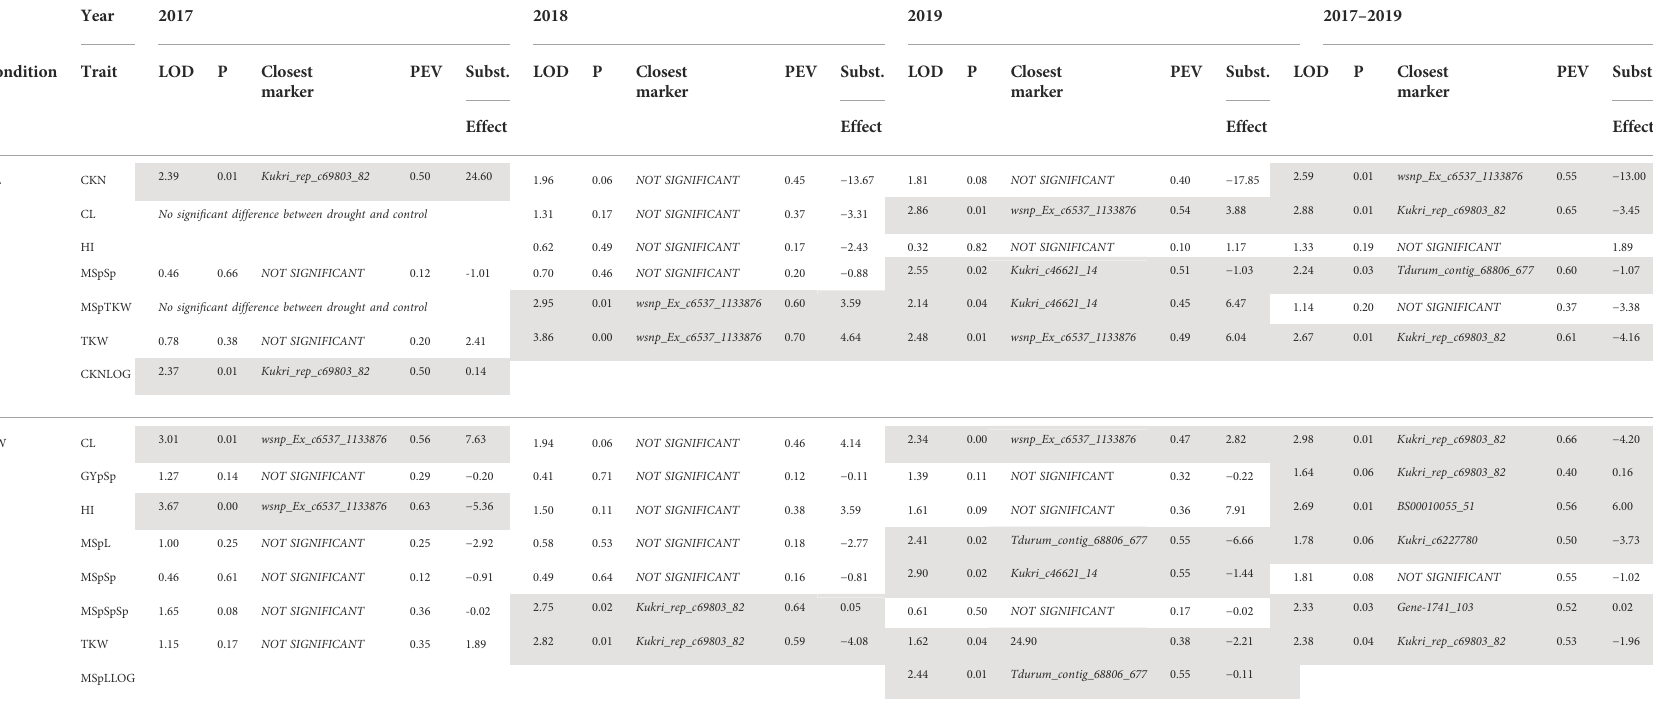
TABLE 3 Signi fi cant QTLs detected in 2017, 2018, and